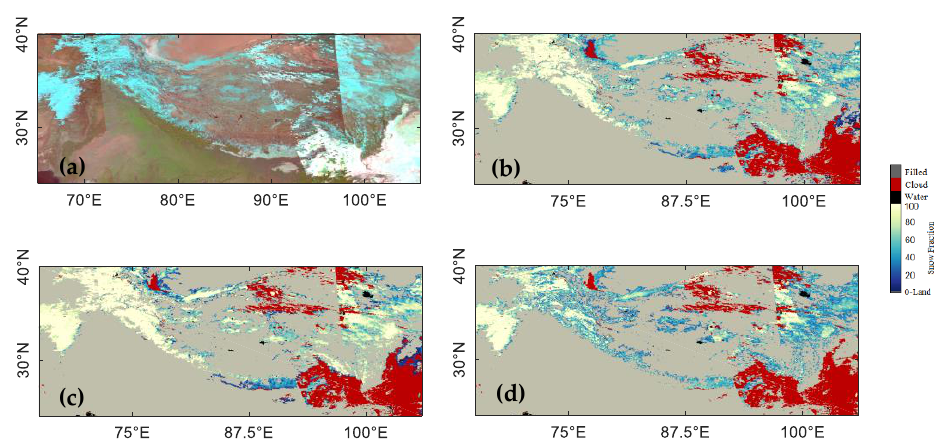
Figure 4. Comparison of the results from the three fractional-snow cover algorithms on the 5 km scale for High Mountain Asia (25 January 1993): ( a ) the false colour image of AVHRR/2 Bands 1, 2, and 3; ( b ) FSC from AVHRR/2 using the MESMA algorithm; ( c ) FSC from AVHRR/2 using the SI algorithm; ( d ) FSC from AVHRR/2 using the TEM